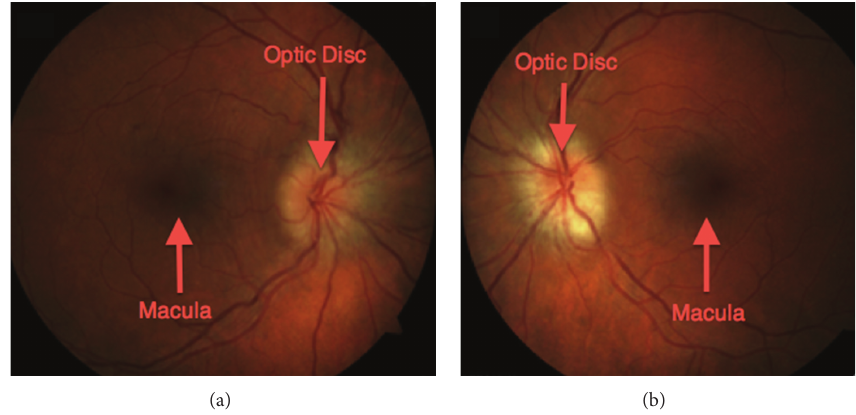
Figure 1: Bilateral diabetic papillopathy. (a) Fundus photo of the right eye showing an edematous and hyperaemic optic disc. Note the peripapillary circumferential retinal striae extending towards the macula signifying subretinal fluid secondary to leakage from the disc. (b) Concurrent fundus photo of the left eye. Significant disc edema is also present. Note the relative pallor of this optic disc compared to that of the right eye suggesting permanent optic nerve damage and